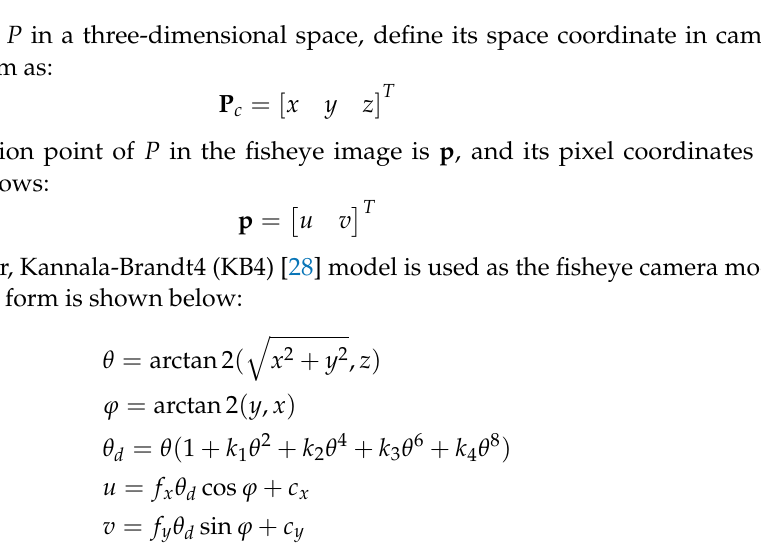
Figure 1. Spherical perspective model ( θ : The FoV latitude angle; ϕ : the FoV longitude